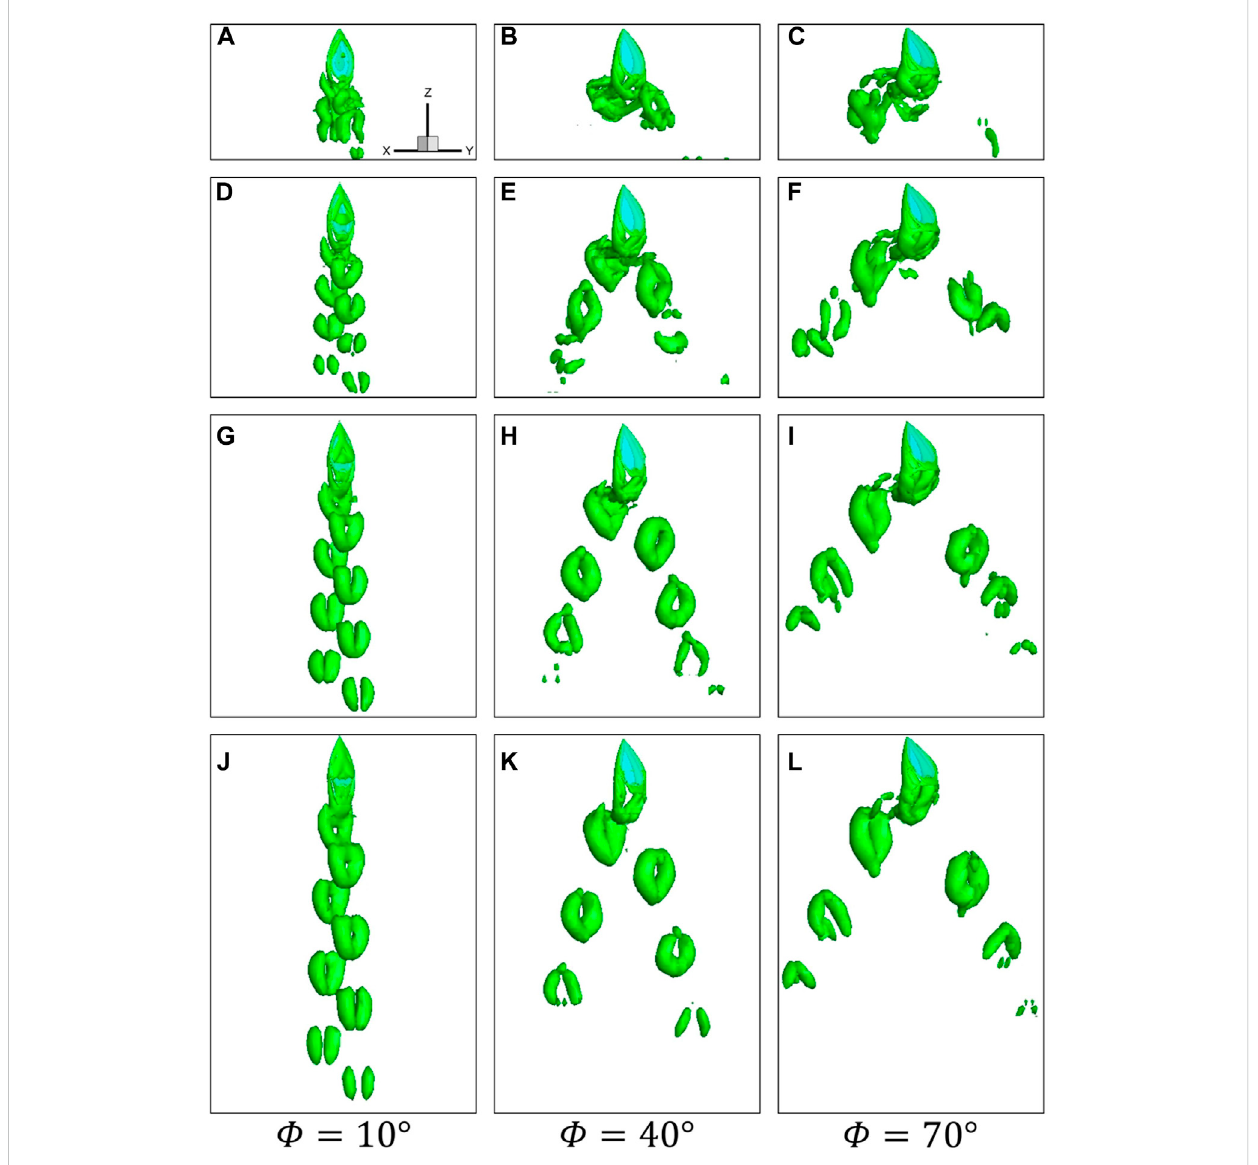
FIGURE 11 Instantaneous vortical structures visualized by the iso-surface of Q (cid:1) 0 . 5 for the wing at V (cid:1) 0 . 25 V 0 (A – C) , 0 . 50 V 0 (D – F) , 0 . 75 V 0 (G – I) , and 1 . 00 V 0 (J – L) for different fl apping amplitudes Φ .